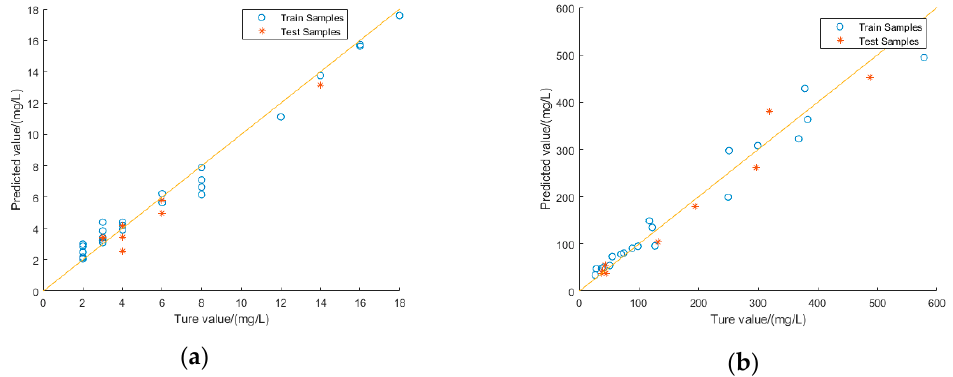
Figure 12. Relationship between the predicted and measured values of suspended solids concentration: ( a ) BR; and ( b ) SP.